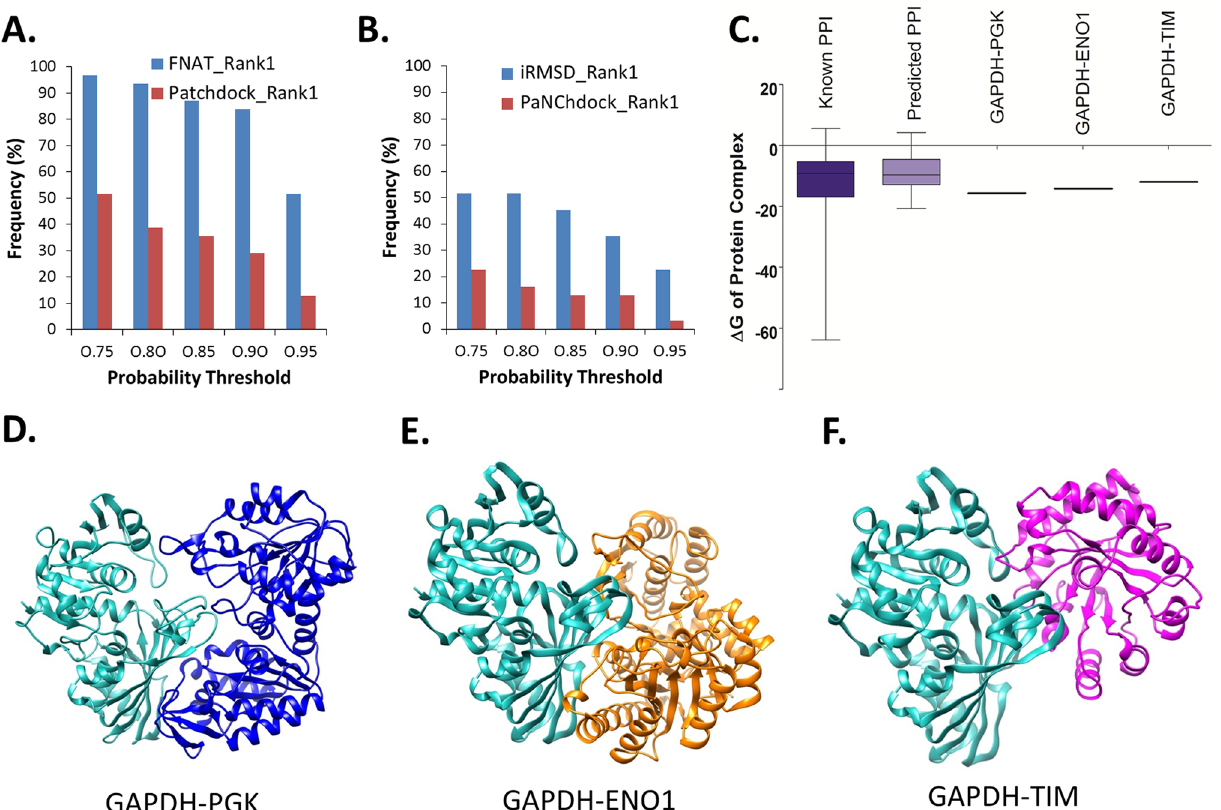
Figure 4. Prediction of probable interaction surface. ( A , B ) The frequency of the probability threshold scores within the FNAT ( A ) and iRMSD ( B ) based top ranked solutions in comparison with same derived from PatchDock based top ranked solutions. ( C ) Box plot representation of the binding energy of the protein–protein interaction interface (represented via ΔG) of the 12 docked complexes that were commonly predicted by both FNAT and iRMSD models with highest reliability (probability threshold ≥ 0.95) along with the same obtained from the known 3D structures of the heterodimer complexes. ΔGs of the three representative complexes of GAPDH-PGK, GAPDH-ENO1, and GAPDH-TIM are also plotted. ( D , F ) show the 3D cartoon representations of the complexes where GAPDH is shown in cyan and the PGK1, ENO1, and TIM are shown in purple, orange, and blue,